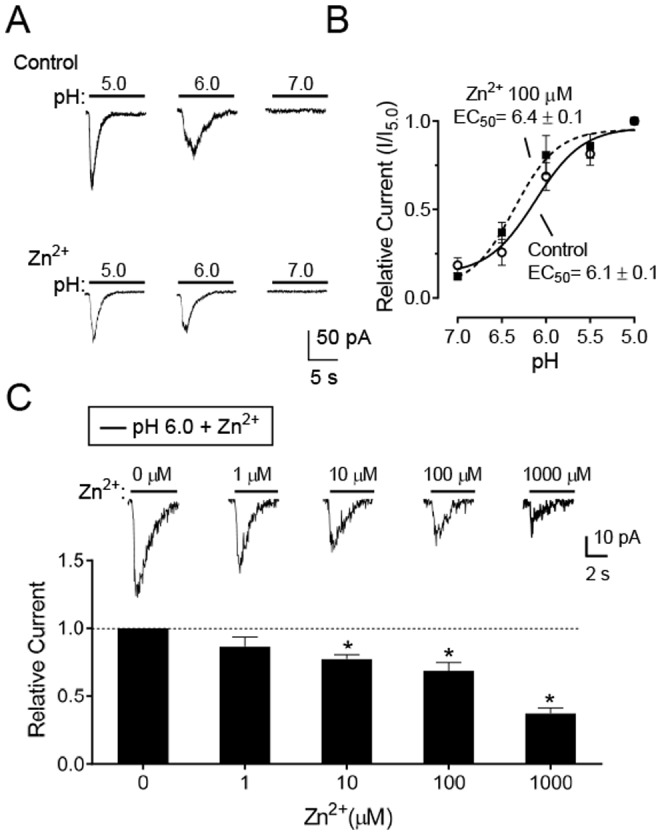
The effects of extracellular Zn2+ on ASIC currents in freshly isolated anterior pituitary cells.
A. Representative pH-dependent activation of ASIC currents in control without (control, upper) and with (lower) 100 µM Zn2+. Cells were perfused with 100 µM Zn2+ at pH 7.4 for 2 min, and then were tested with solutions at the indicated pHs (∼5 sec) that also contained 100 µM Zn2+. B. Best-fit of the pH-dependent activation of ASIC currents yielded an EC50 pH of 6.1±0.1 (control, n = 8) and 6.4±0.1 (with 100 µM Zn2+, n = 8). C. Top, representative data of the dose-dependent effect of Zn2+ on ASIC current amplitude. Zn2+ concentrations from 0 µM to 1 mM at pH 7.4 were applied for 2 minutes and ASIC currents were activated by 5 s of pH 6.0 with the same Zn2+ concentration. Bottom, average data of the inhibitory effects of Zn2+ (n = 9). * P<0.05, compared with 0 µM Zn2+ group, one-way ANOVA with Dunnett's multiple comparison test.